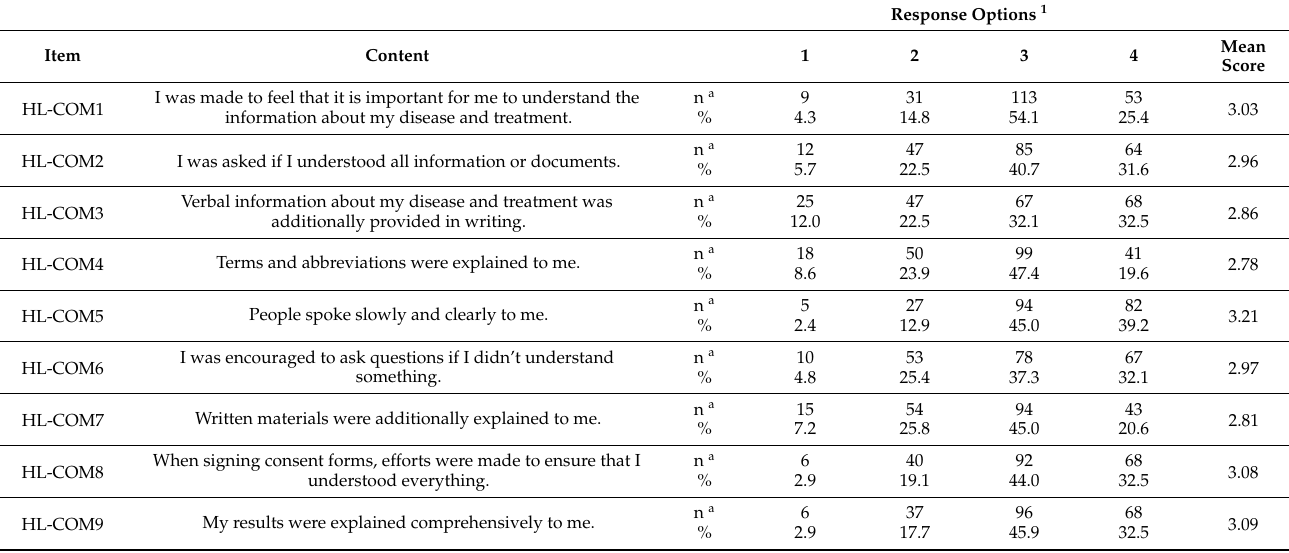
Table 1. Items of HL-COM and frequency of response